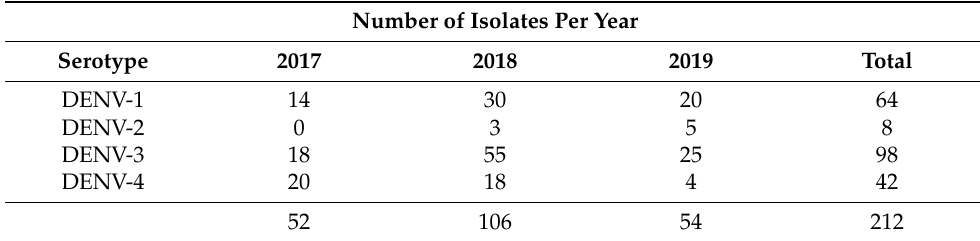
Table 1. Distribution of DENV serotypes circulating in Yangon, Myanmar